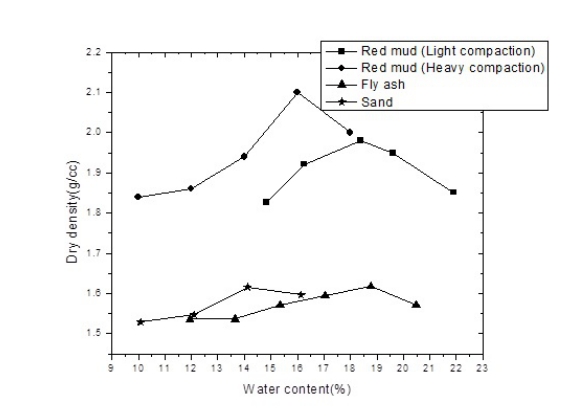
Figure 5. Compaction characterisation of red mud with fly ash and local soil